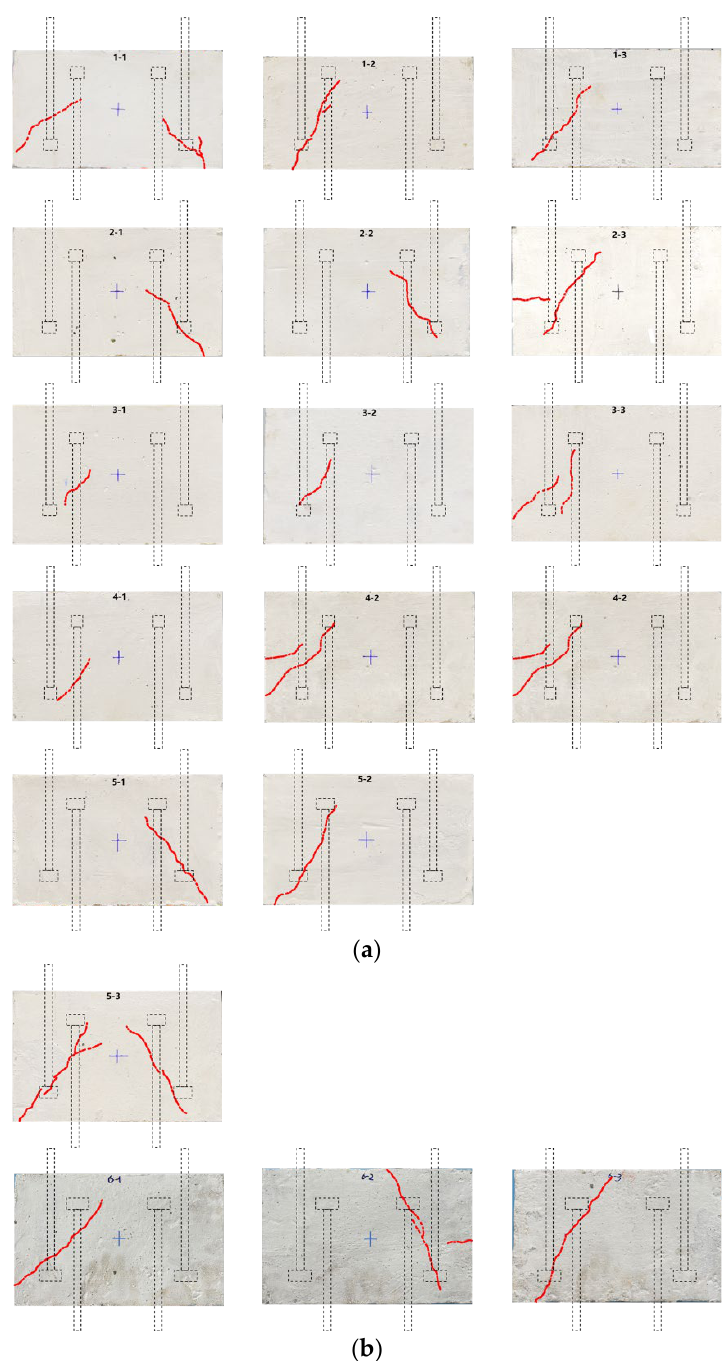
Figure 10. Crack development at peak load for all the specimen ( a ) Steel bar connector failure; ( b ) Steel bar rupture failure.